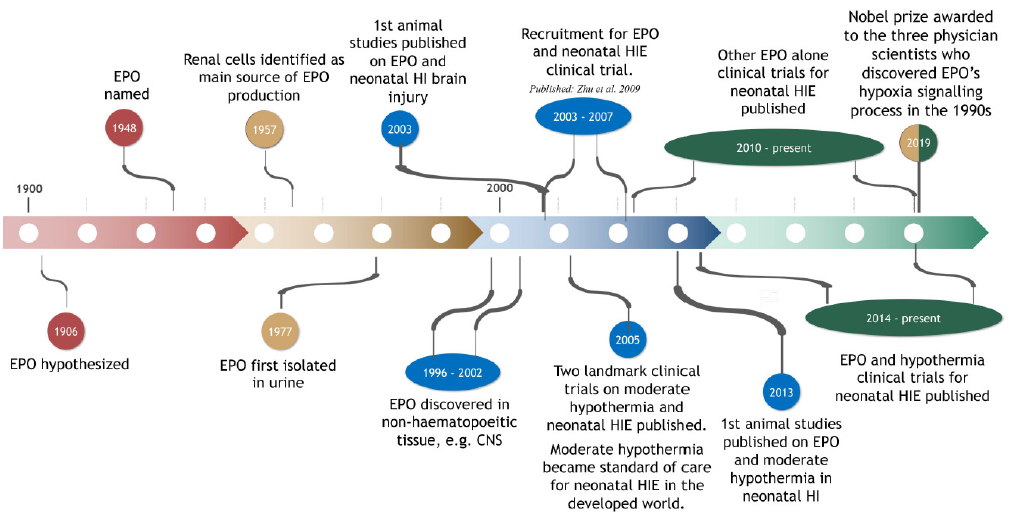
Figure 1. Timeline of the history of EPO in the context of its discovery, hypoxia-induced signalling processes (and the associated Nobel Prize), its use in animal studies on perinatal hypoxia-ischemia (HI) and its use in clinical trials on neonatal hypoxic-ischemic encephalopathy (HIE).